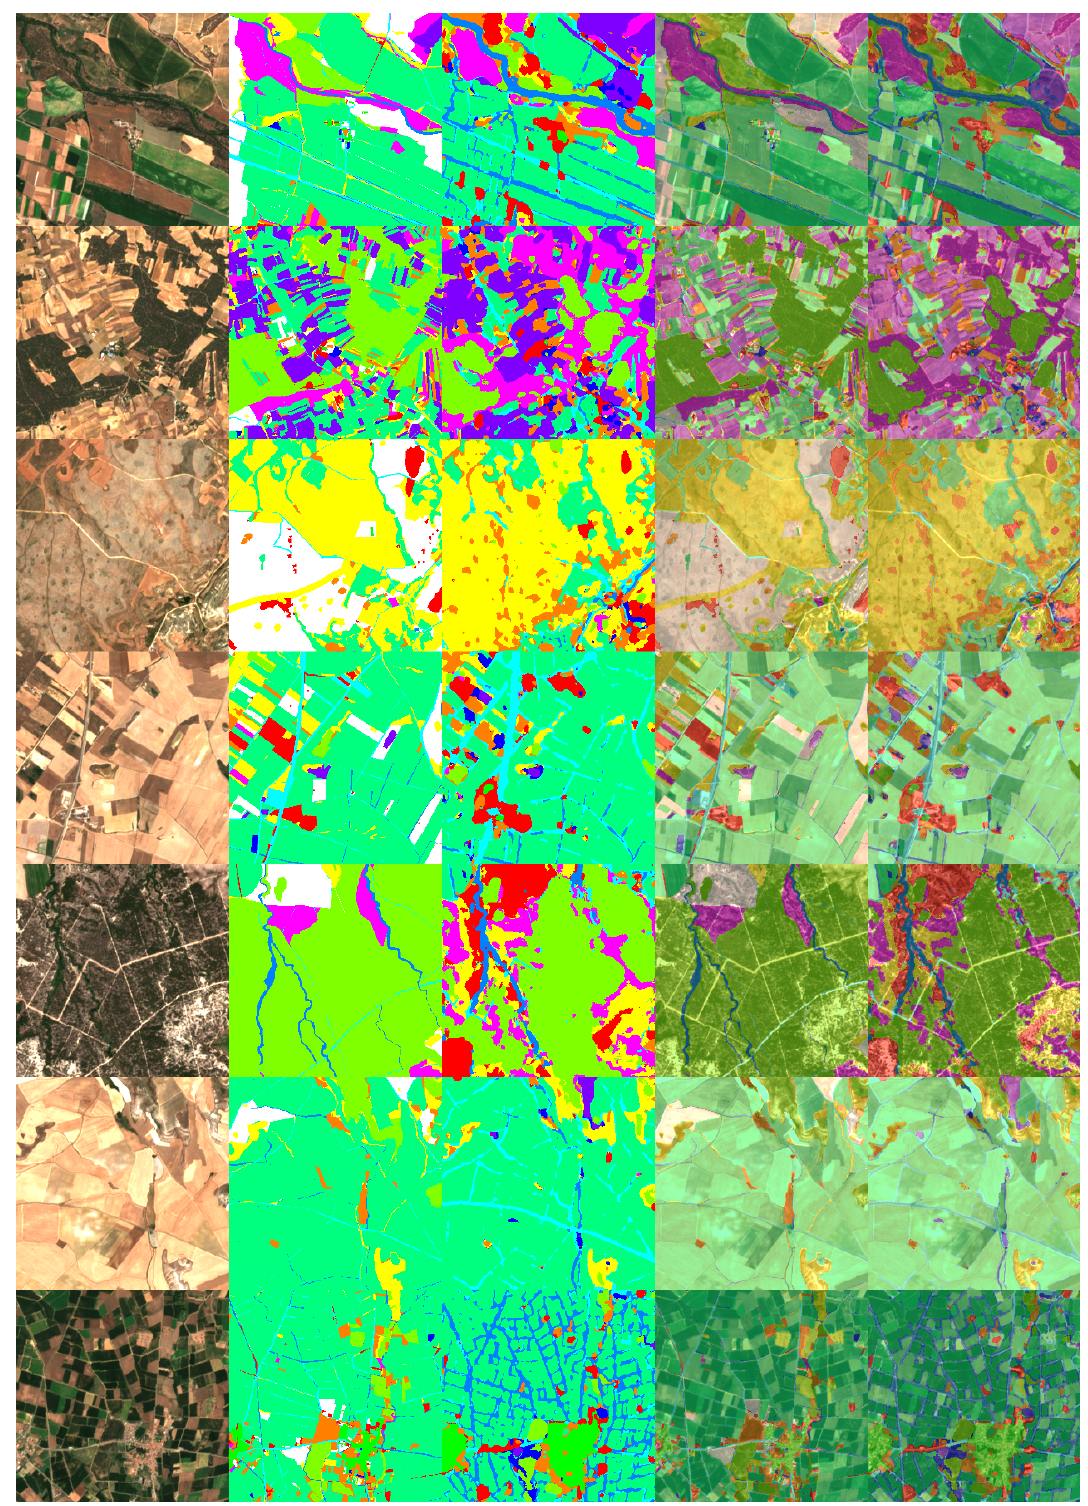
Figure 14. Visualization of the predicted results for UNet evaluated in UOS2 (Experiment Base). ( 1st col. ) Original images, ( 2nd col. ) ground truth masks, ( 3rd col. ) predictions, ( 4th col. ) overlapping of original images with ground truth masks, ( 5th col. ) overlapping of original images with